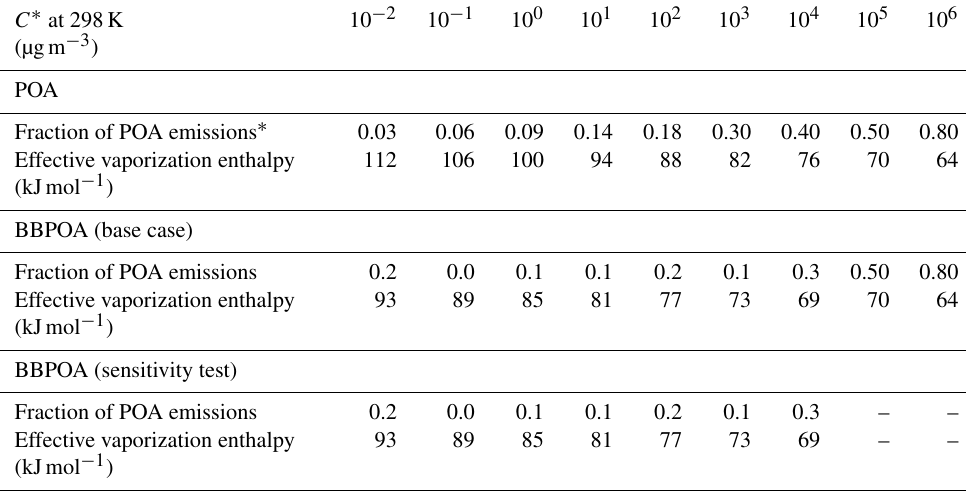
Table 1. Parameters used to simulate POA and BBPOA emissions in PMCAMx-SR. C ∗ at 298K